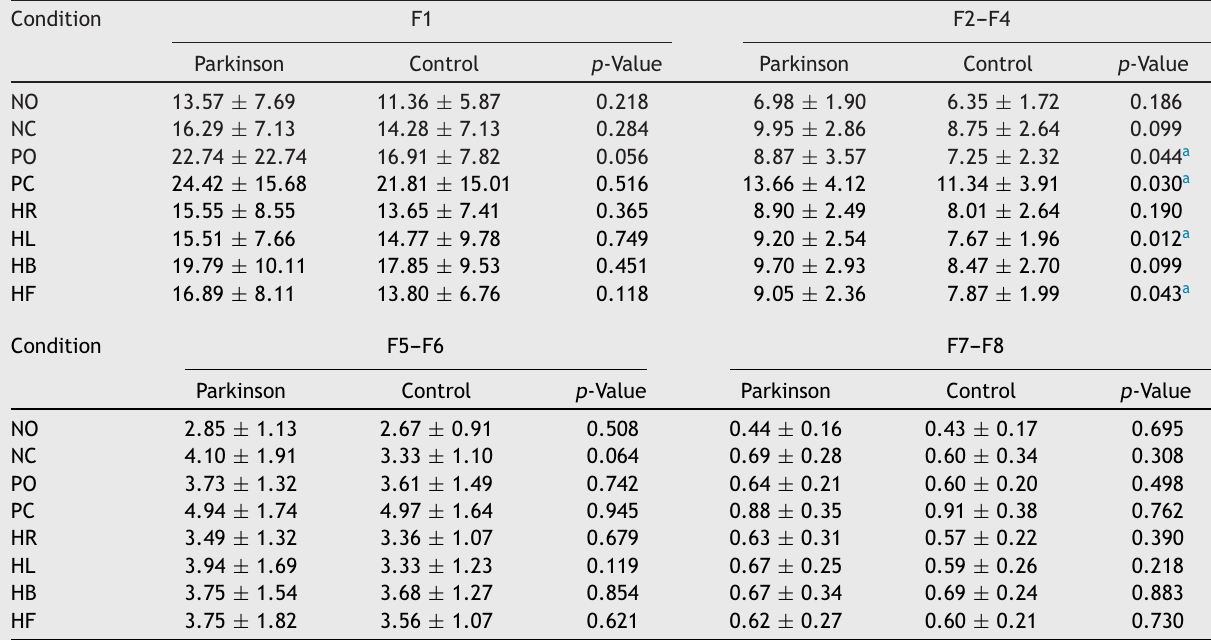
Table 2 Comparative analysis of Fourier frequency ranges in the eight conditions of the Tetrax TM interactive balance system in 29 control subjects and 30 patients with Parkinson’s